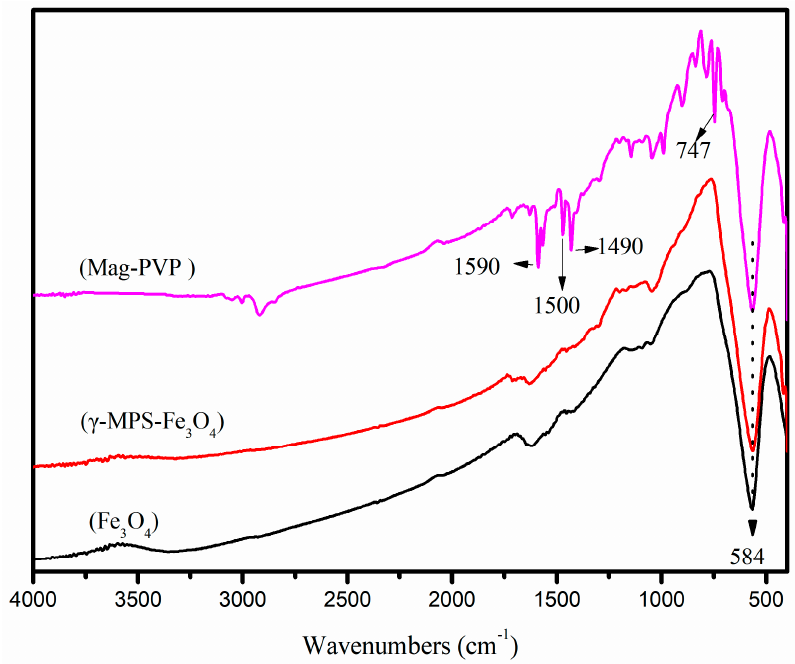
Figure 2. FTIR spectrum of Fe 3 O 4 , γ -MPS-Fe 3 O 4 , and Mag-PVP.